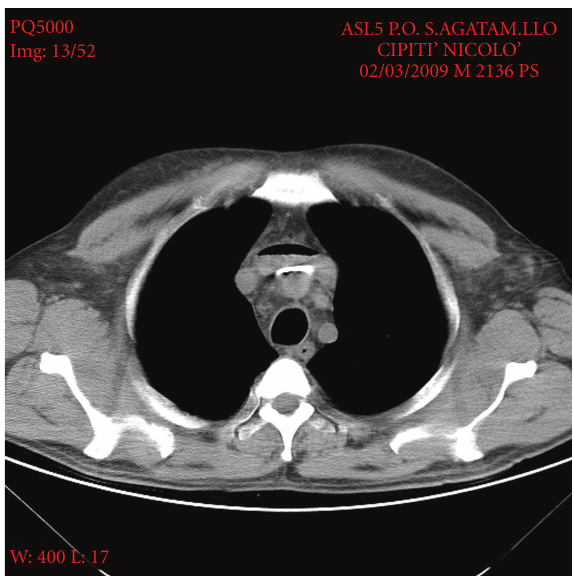
Figure 1: CT scan showing air bubbles trapped at the level of the venous brachiocephalic trunk.